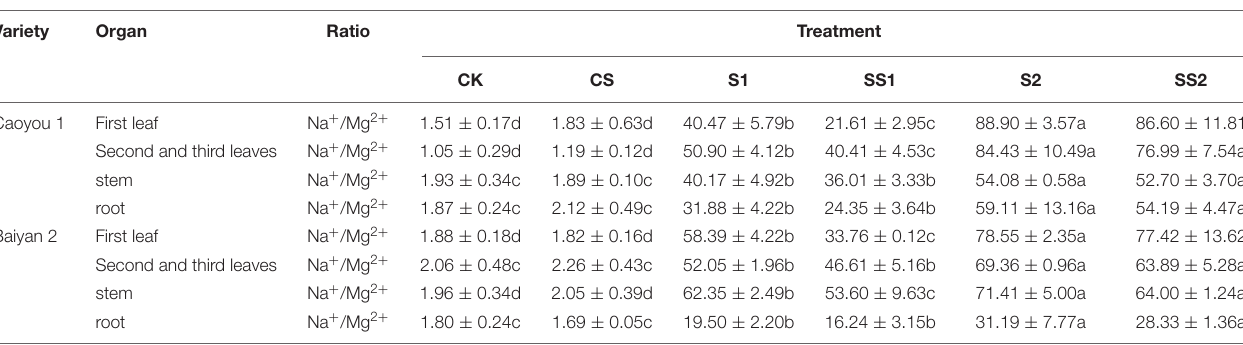
TABLE 3 | Effects of Spd application on Na + /Mg 2 + ratio under salt stress in the oat seedlings.